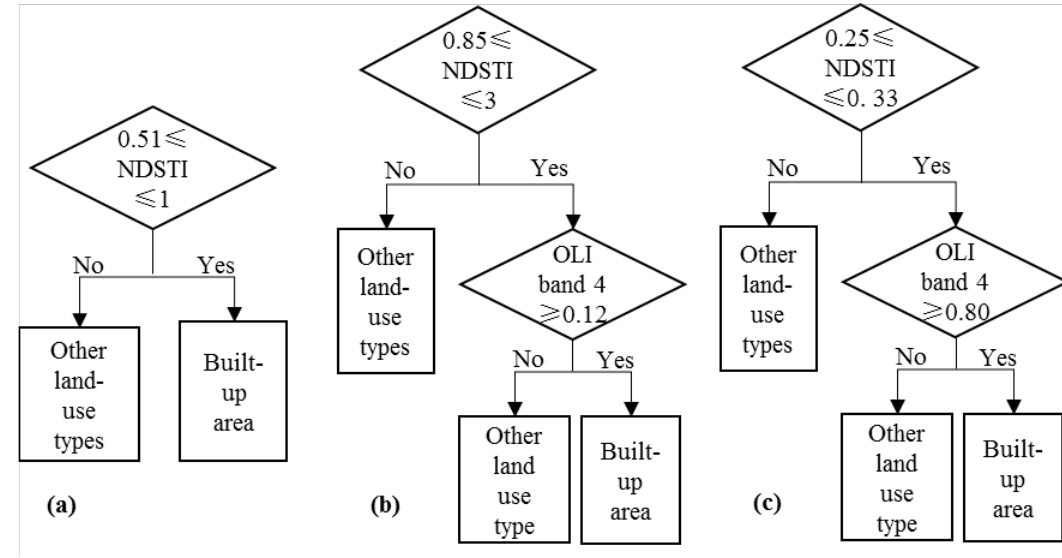
Figure 7. The decision tree of ( a ) Minqin, ( b ) Laizhou, and ( c ) and Yugan.